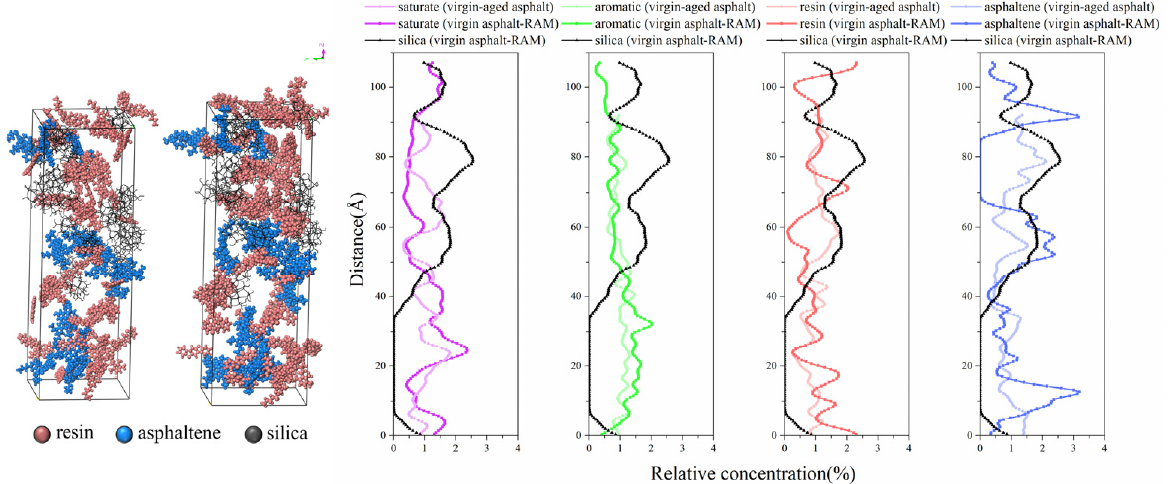
Figure 8. Relative concentration distribution of SARA components of asphalt.